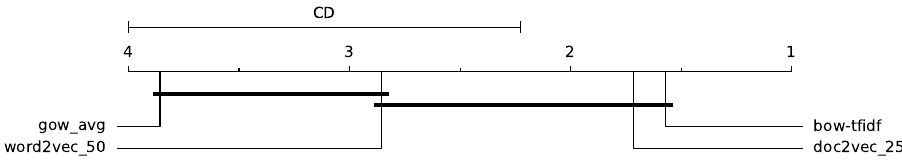
Figure 2. Average ranks of the four top-performing variants of the document representation models in each of the four groups with respect to the macro-averaged AUROC.